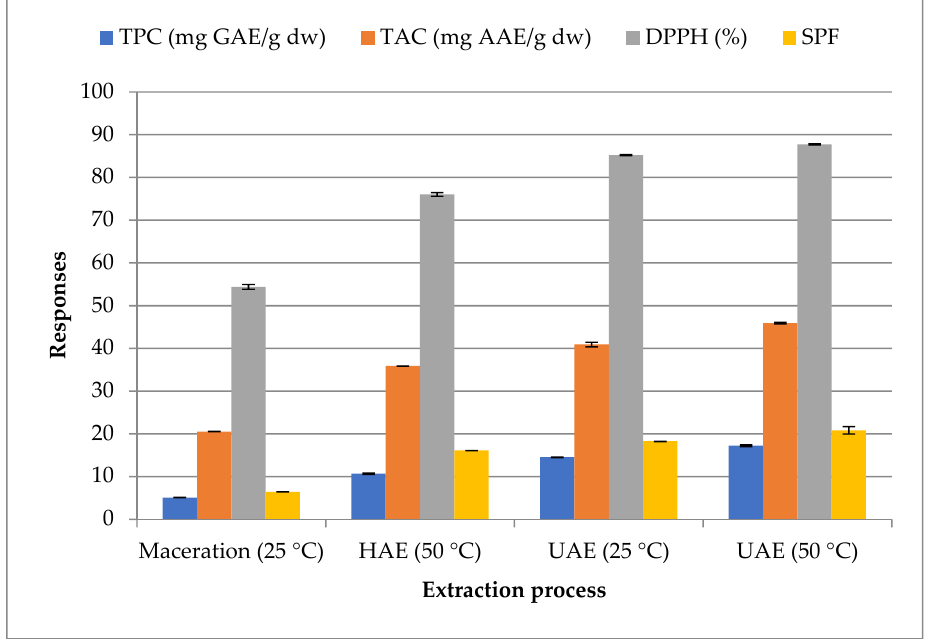
Figure 2. Effect of extraction process and temperature on responses. HAE—heating-assisted extraction, and UAE—ultrasound-assisted extraction.